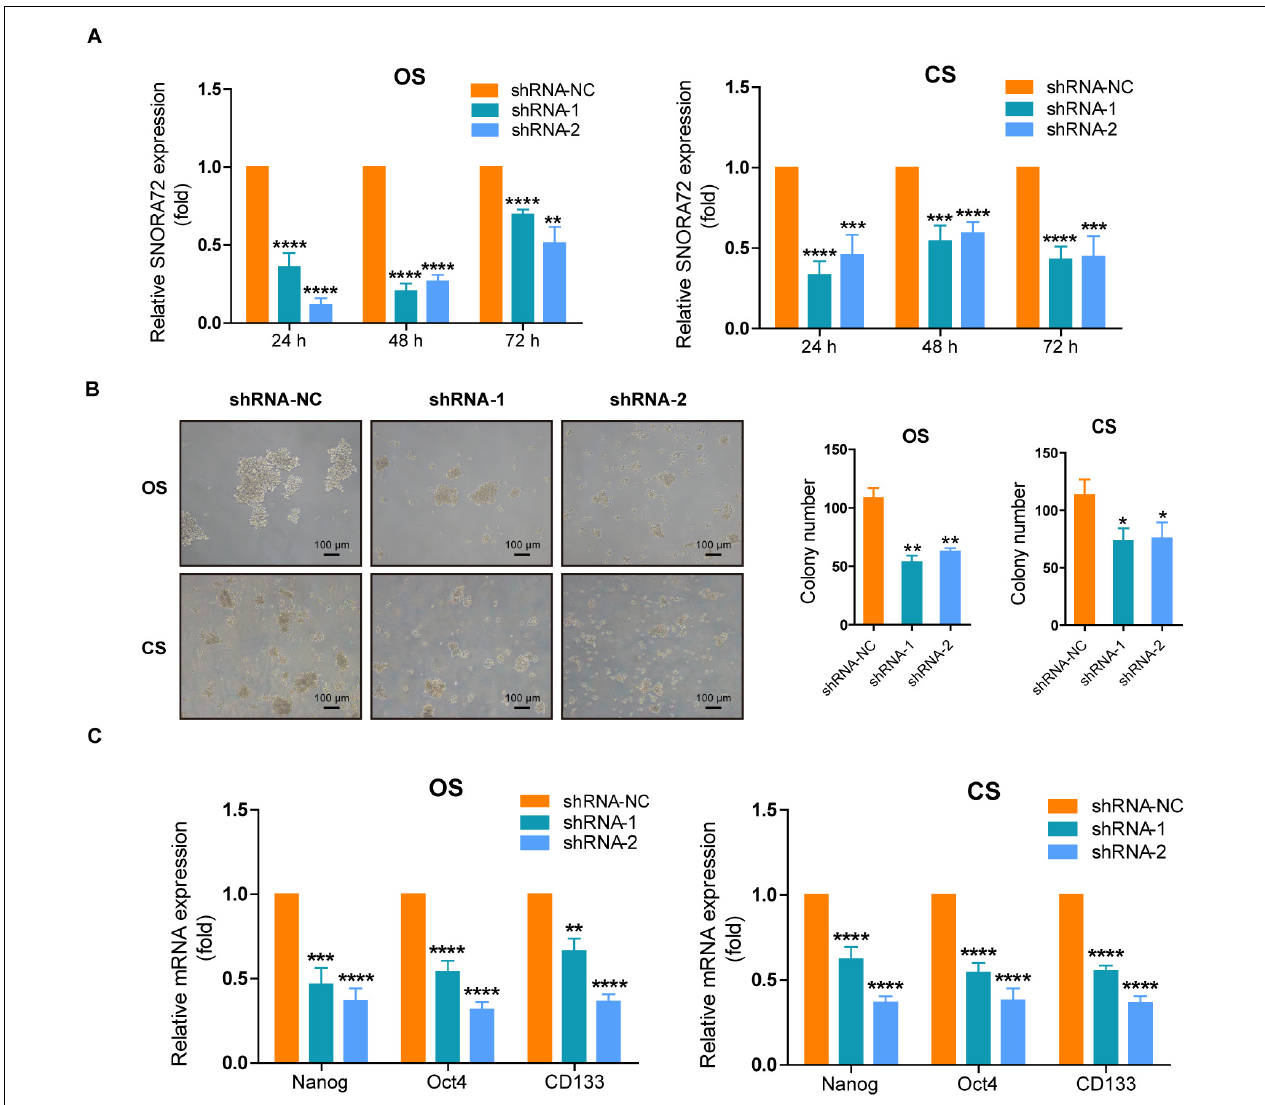
FIGURE 3 | SNORA72 knockdown decreases the self-renewal of OVCAR-3 spheroid (OS) and CAOV-3 spheroid (CS) cells. (A) Expression of SNORA72 determined in OS and CS cells at 24, 48, and 72 h after transfection of the SNORA72 silencing (shRNA-1 and shRNA-2) or control (shRNA-NC) plasmids by quantitative reverse transcription PCR (qRT-PCR) analysis. (B) Self-renewal abilities were measured by colony formation assays in OS and CS cells transfected with the shRNA-1, shRNA-2, or shRNA-NC plasmids. (C) Relative mRNA expressions of Nanog, Oct4, and CD133 to β -actin, as an endogenous control, analyzed by qRT-PCR in OS and CS cells after transfection of the shRNA-1, shRNA-2, or shRNA-NC plasmids for 48 h. The expression level in OS and CS cells after transfection of shRNA-NC plasmids was set as 1. * P < 0.05, ** P < 0.01, *** P < 0.001, and **** P < 0.0001.